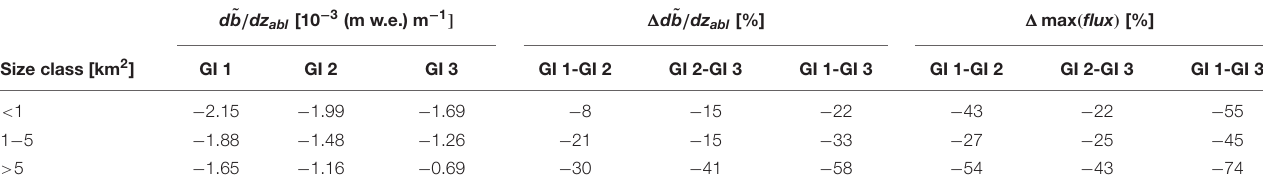
TABLE 1 | ˜ b / dz abl , its changes (cid:49) d ˜ b / dz abl and changes of the maximum modeled flux (cid:49) max ( flux ) between the glacier inventories (GI) separated for the three glacier size